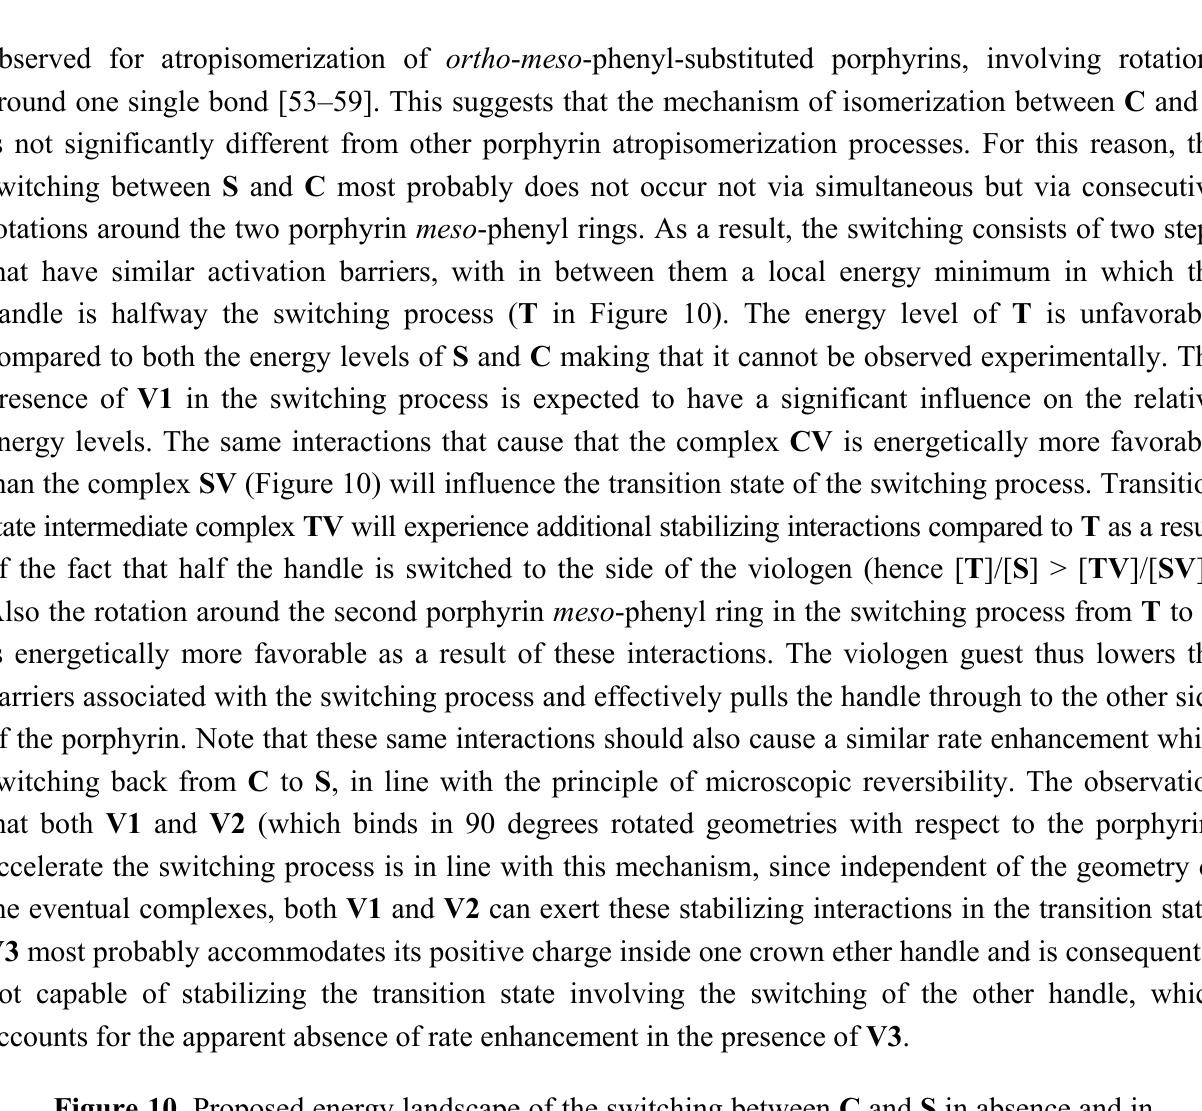
Figure 10. Proposed energy landscape of the switching between C and S in absence and in the presence of V1